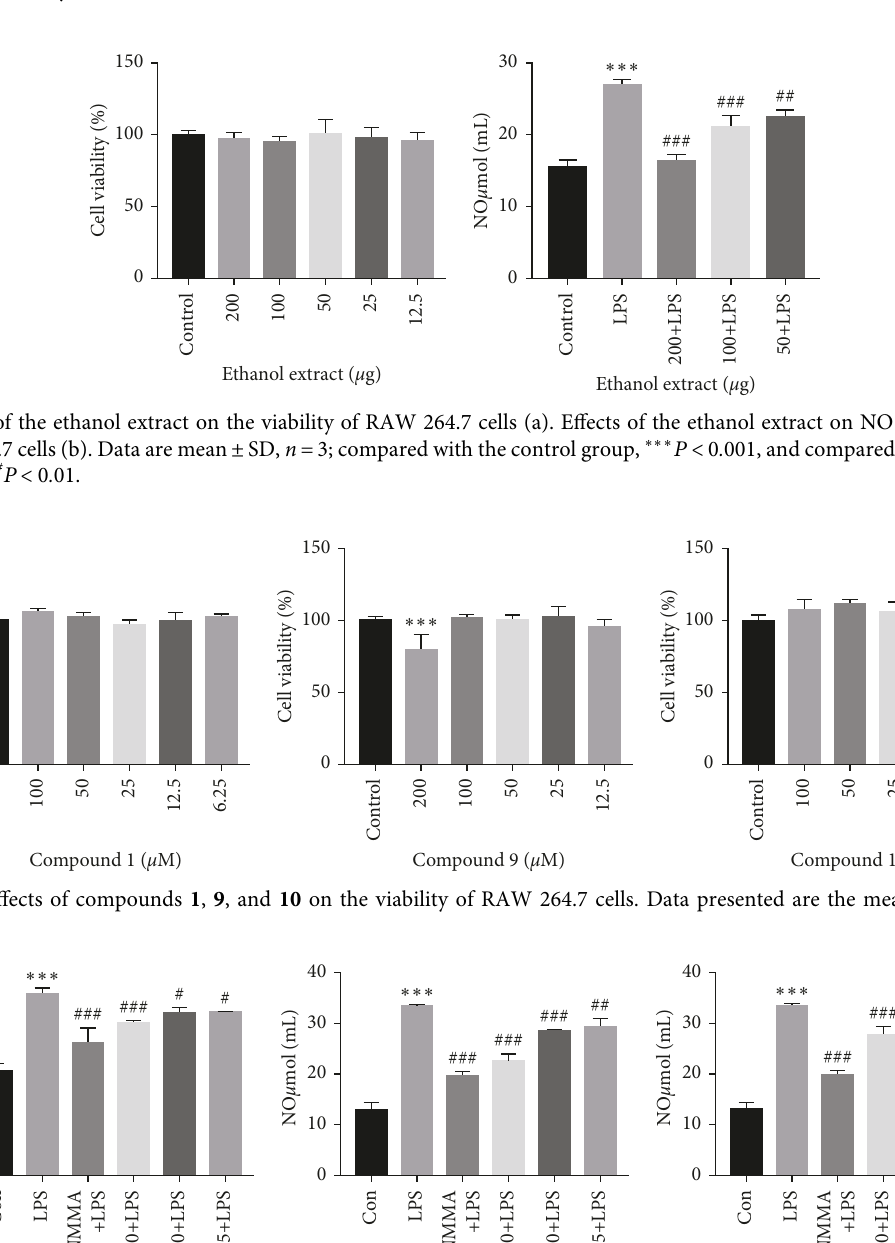
Figure 4: Effects of compounds 1 , 9, and 10 on NO production in LPS-induced RAW 264.7 cells. Data presented are the mean Compared with the control group,